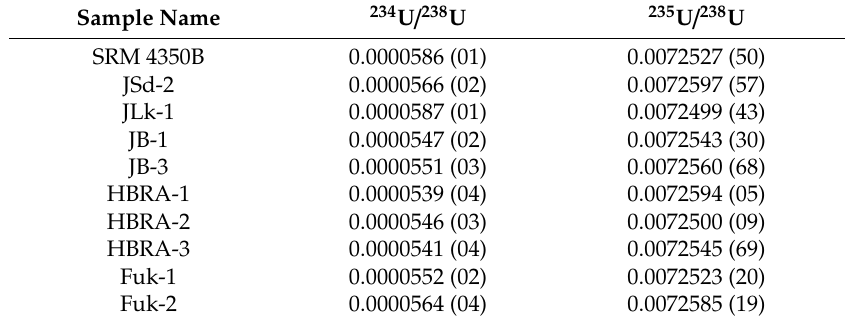
Table 5. Uranium isotope ratios in reference materials and environmental samples using MC-ICP-MS.